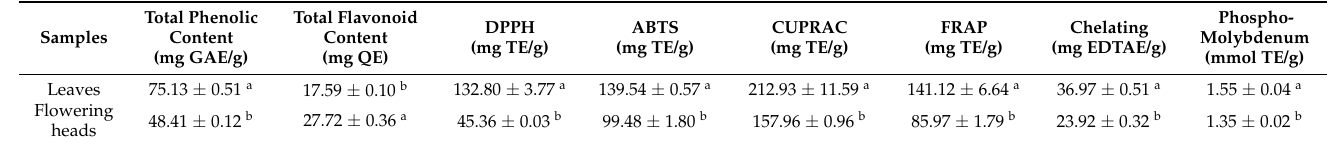
Table 2. Total phenolics, and flavonoids content and antioxidant activity of C. alpina